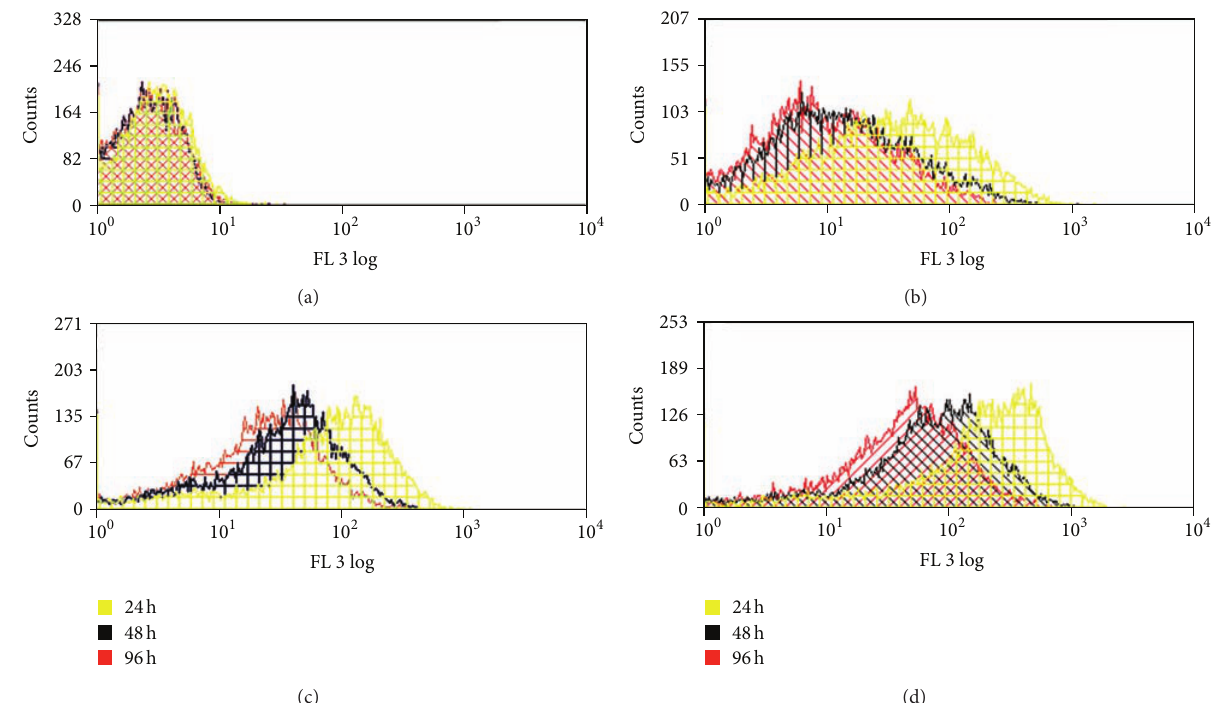
Figure 3: FACS analysis of QDs cell load over cultivation time. The fluorescence per cell was analysed after 24h, 48h, and 96 h. (a) Control cells without QDs, (b) cells labeled with 5 nM QDs, (c) cells labeled with 10nM QDs, and (d) cells labelled with 20nM QDs.